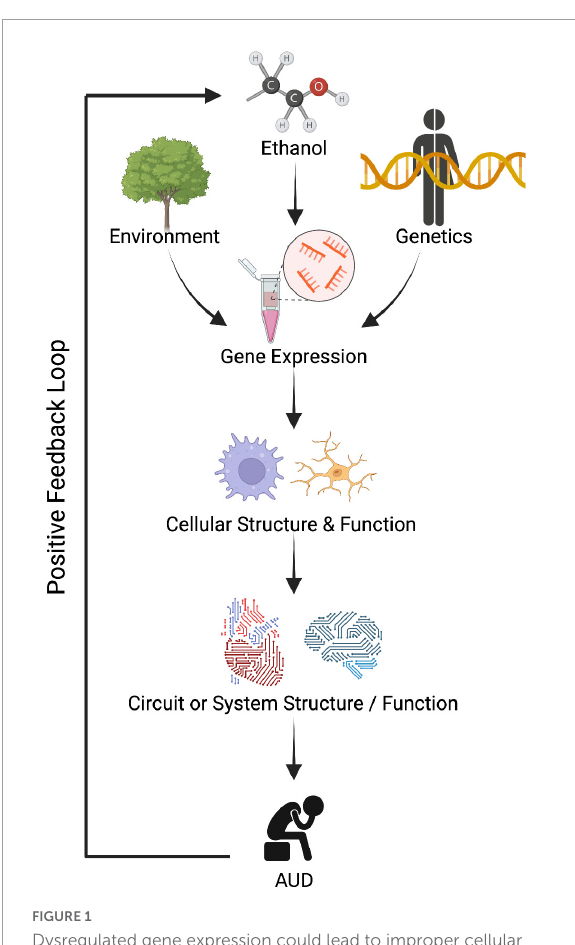
FIGURE1 Dysregulated gene expression could lead to improper cellular function, circuit function, and eventually contribute to abnormal behavior observed in alcohol use disorder (AUD). Created with